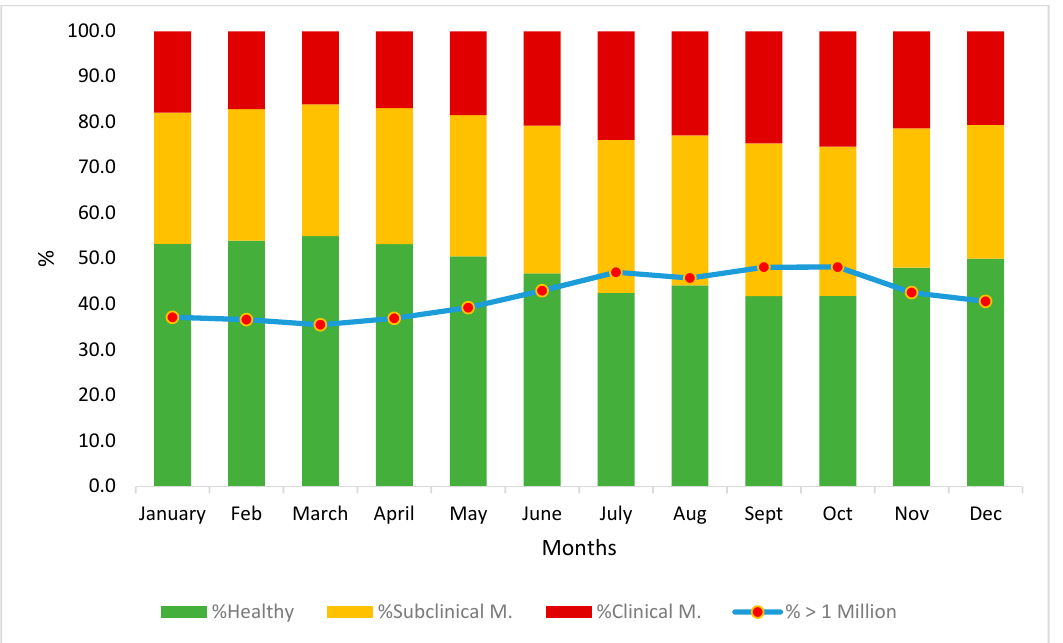
Figure 4. Estimation of the evolution of subclinical and clinical mastitis throughout the year (presence or absence of mastitis) based on criteria of Paape et al., 2001 (healthy > 1 million as suspected of mastitis) and Renée de Crémoux, 2012 (healthy, subclinical, or clinical mastitis).